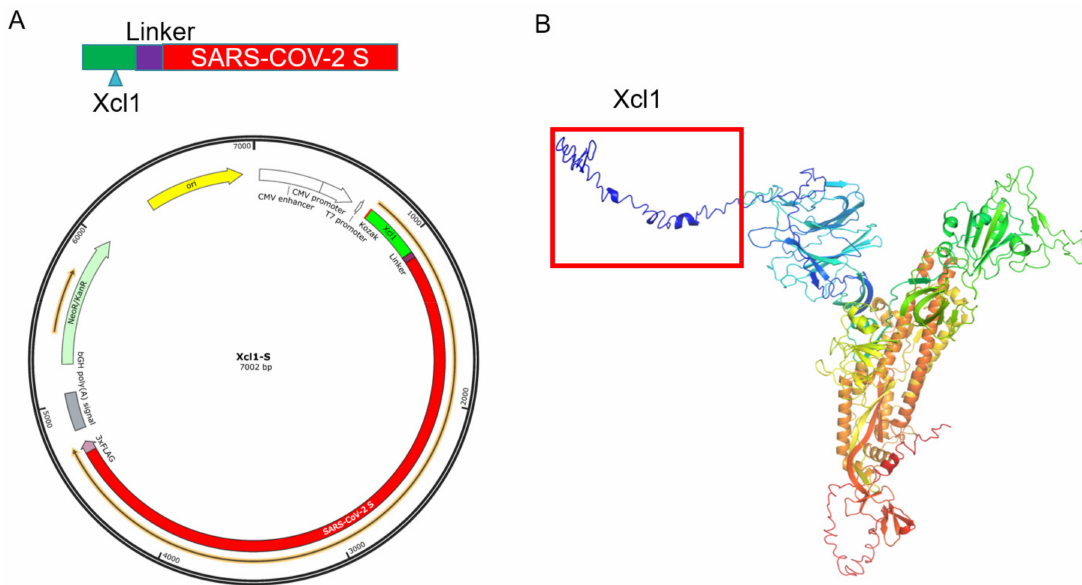
Figure 1. Design and prediction of the structure of Xcl1-S synthetic DNA vaccine constructs. ( A ) Schematic diagram of the Xcl1-S synthetic DNA vaccine construct. The glycine(5)–serine– glycine(5) linker sequence was inserted between the Xcl1 C-terminus and SARS-CoV-2 spike protein N-terminus. ( B ) Xcl1 maintains its conformation in the fusion protein, as analyzed with the online structure prediction server (https://zhanggroup.org/, accessed on 20 July